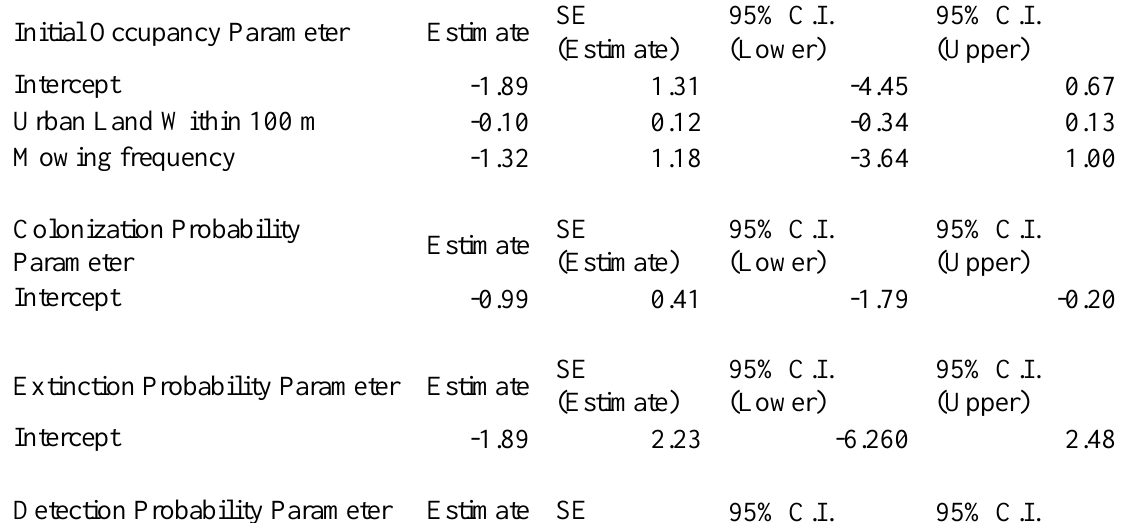
Table A3.D. Third-highest-ranking multi-season occupancy model (AIC AIC weight=0.08) for Le Conte’s Sparrows along 47 transmission line study sites in Winnipeg, Manitoba, Canada in 2008-2009 (n=276 surveys), assuming no effect of mowing on probability of colonization or extinction, and no effects of Julian date, time of morning or observer experience on probability of detection given presence at